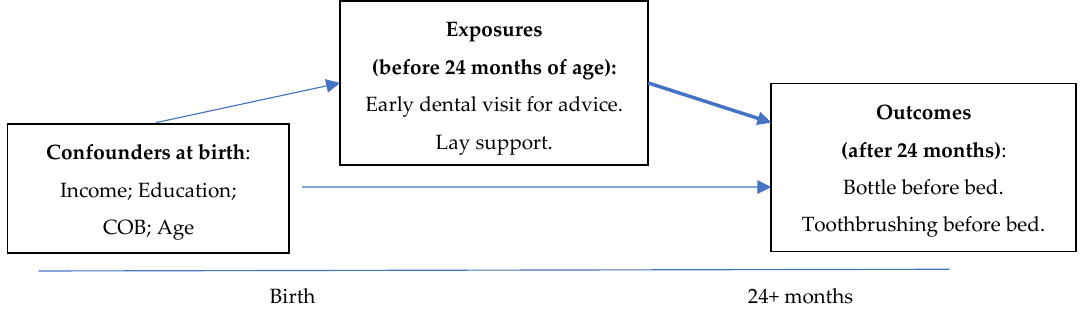
F igure 1. Schematic design of the study. Figure 1. Schematic design of the